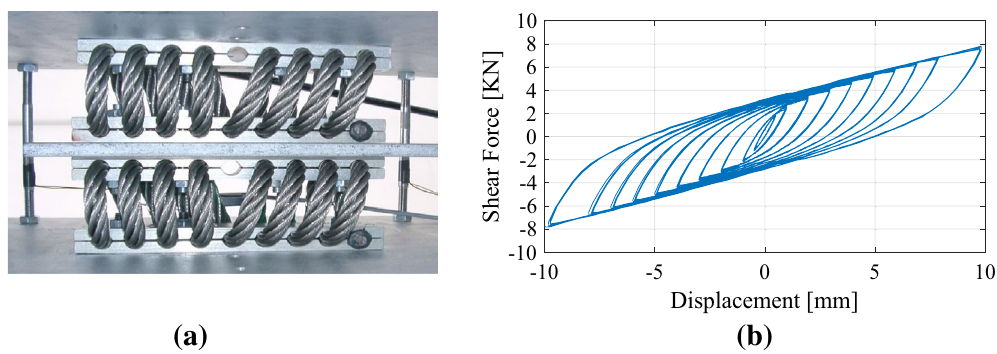
Figure 4. ( a ) Two wire ropes with a central plate subjected to simple shear; ( b ) hysteretic response of the wire rope under cyclic shear loading after Paolacci and Giannini 9